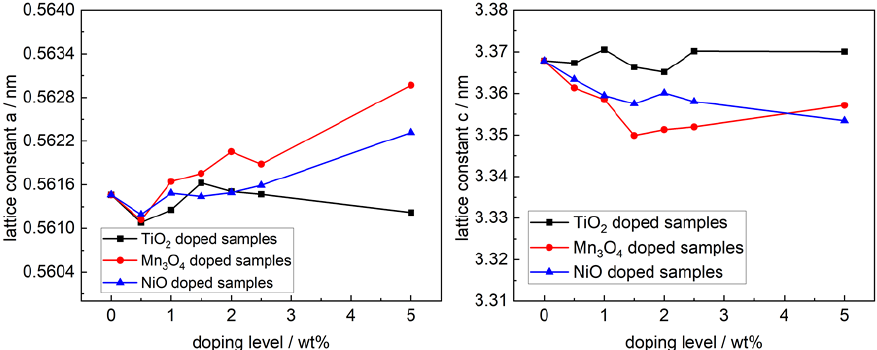
Figure 4. Crystallographic lattice parameters a and c of Na- β″ -alumina samples sintered at 1600 °C.